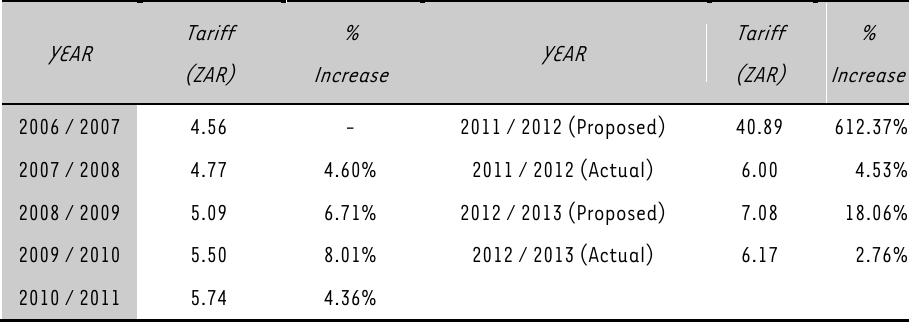
Port tariffs for wood chips over the past seven